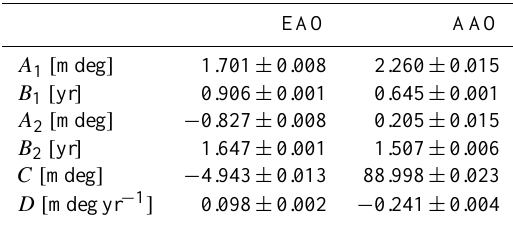
Table 2. Fitted parameters and its errors according to Eq. (4) of the trend analysis for the elevation angle offset (EAO) and the azimuth angle offset (AAO, see Sect.